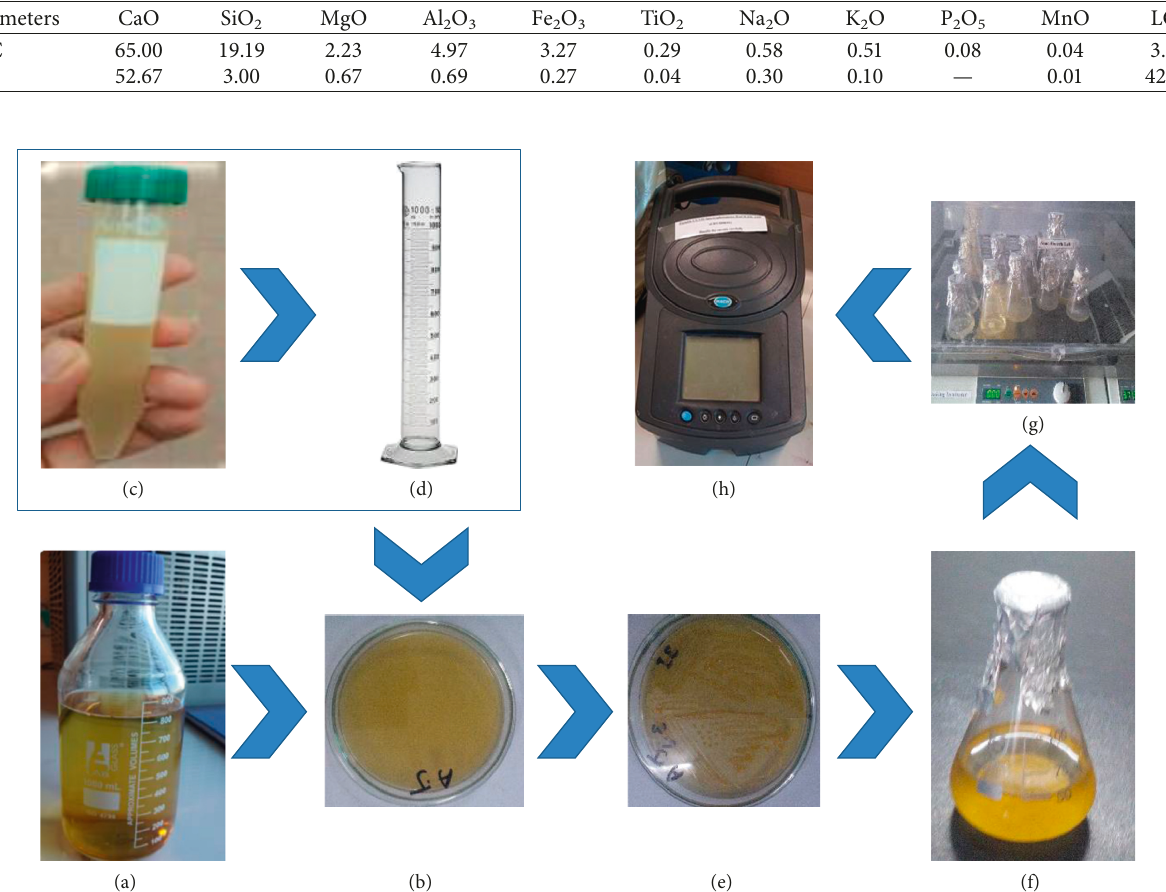
Figure 1: Microbial solution preparation. (a) LB media. (b) Agar plating for growth of microbial colonies. (c) B. subtilis spores. (d) Distilled saline. (e) Microbial colonies. (f) Inoculum in LB. (g) Incubation in shaker. (h) OD